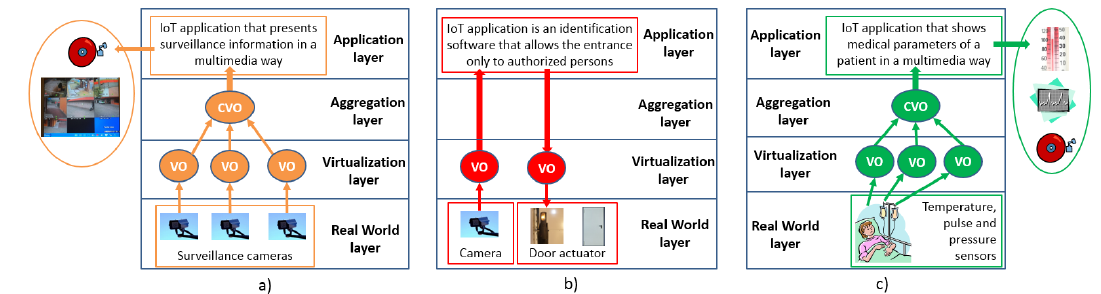
Figure 3. Multimedia IoT (MIoT) scenarios: ( a ) multimedia as IoT input and output: IoT